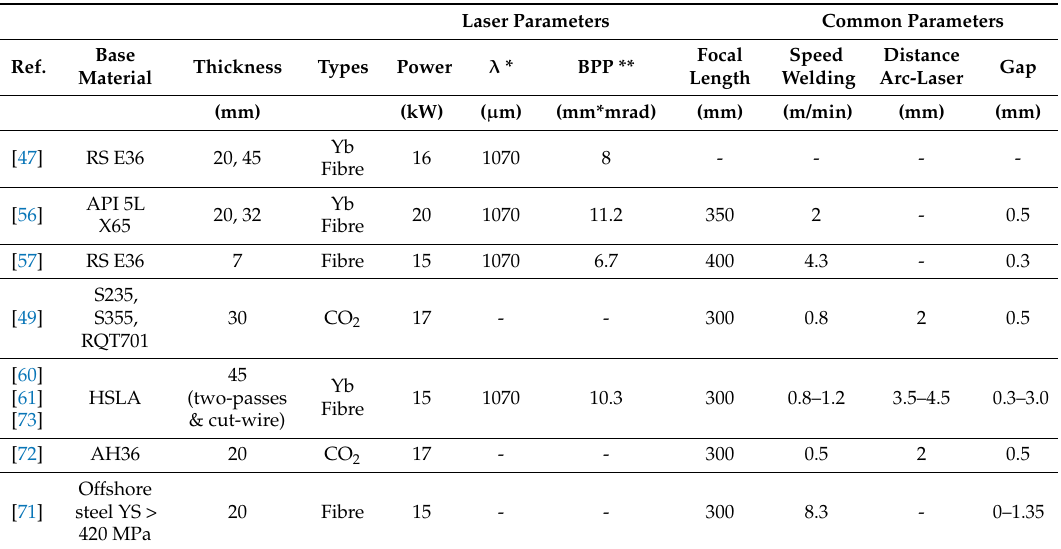
Table 8. Values range of parameters of LAHW. Laser Parameters Common